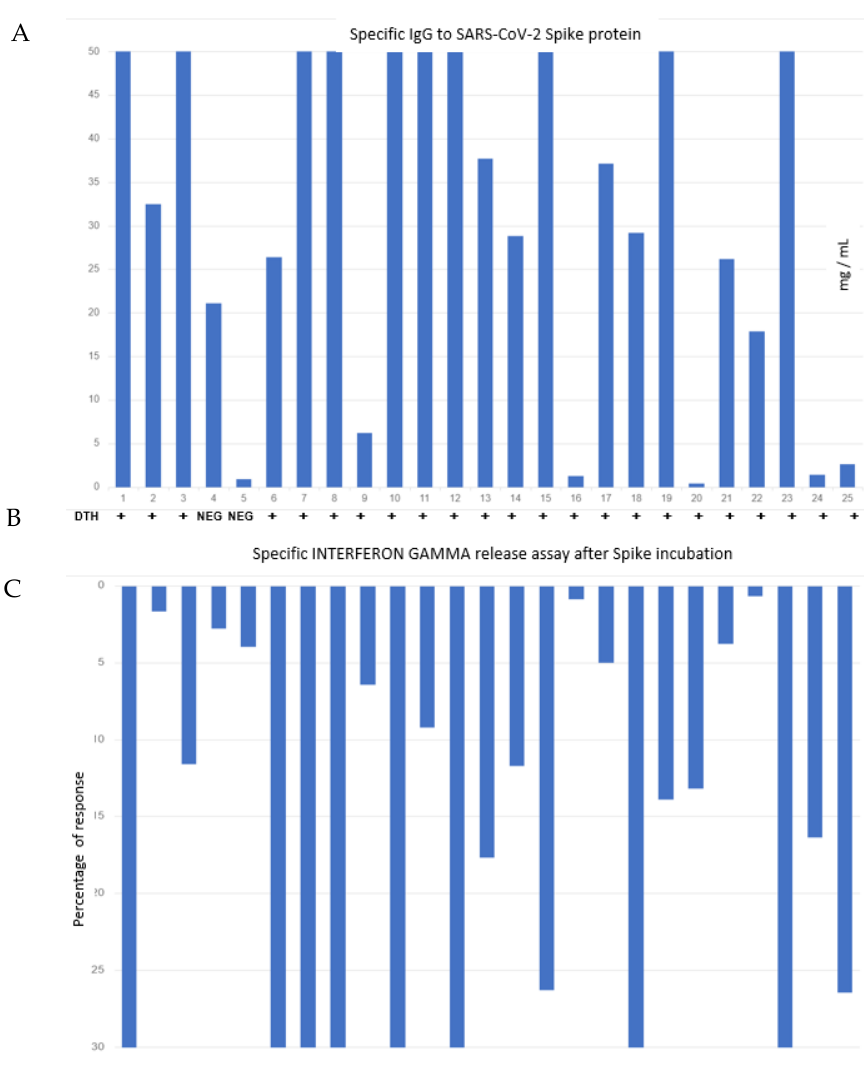
Figure 1. ( A ) Levels of specific antibody IgG against spike protein in mg/mL. Levels above 5 mg/mL are considered as positive serology. ( B ) Table with results of DTH (qualitative) in every single patient. ( C ) Percentage of response with respect to the levels of interferon gamma present in the supernatant after the incubation of whole blood from each patient with the SARS-spike protein. Levels beyond 5% are considered positive.